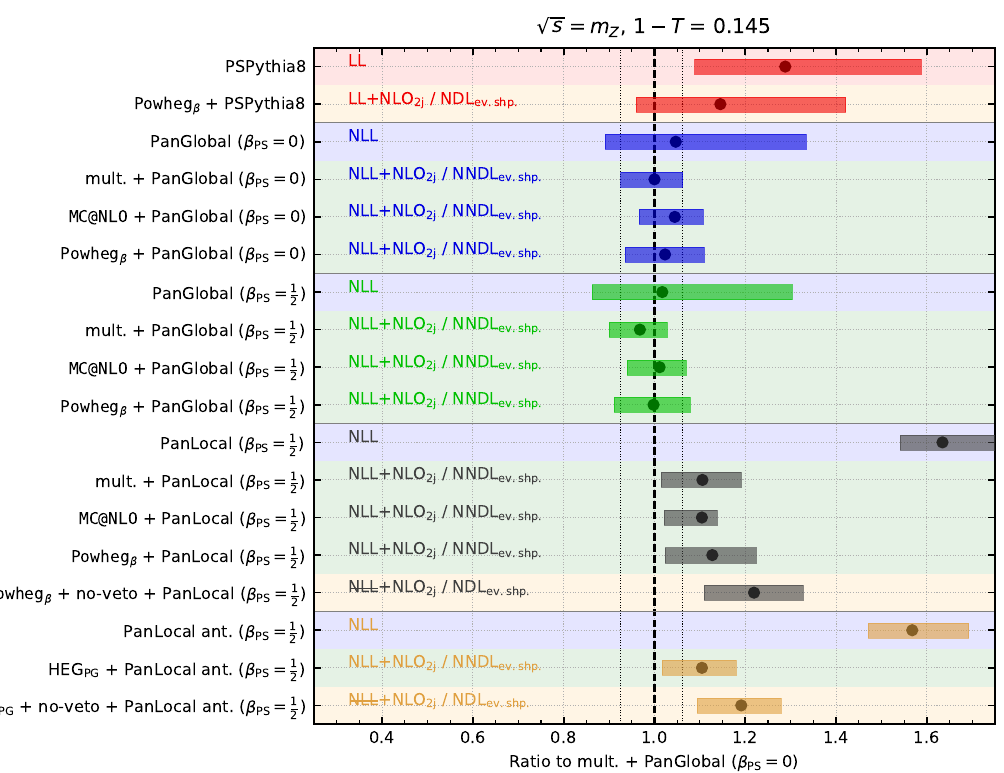
Figure 10. Ratio of multiple shower/matching scheme combinations to the multiplicatively- matched PanGlobal β = 0 shower in a bin 0 . 14 < 1 − T < 0 . 15 of the thrust distribu- ps tion. The error bands represent the scale uncertainty and are colour-coded differently for each “main” shower, while the background colour reflects the accuracy of the matching/shower com- bination, i.e. LL (red), LL+NLO /NDL or NLL+NLO /NDL (yellow), NLL (blue), 2 j ev . shp . 2 j ev . shp . and NLL+NLO /NNDL (green). The thin dotted vertical lines indicate the size of the scale 2 j ev . shp . uncertainties for the reference results, i.e. multiplicatively-matched PanGlobal β = 0 . Recall from ps section 3.1 that the NLL notation indicates a breaking of